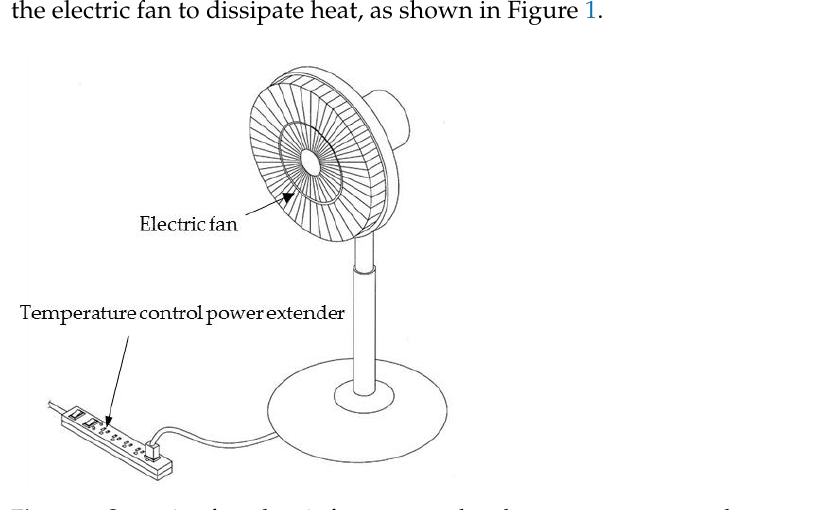
Figure 1. Scenario of an electric fan connected to the temperature control extensor.